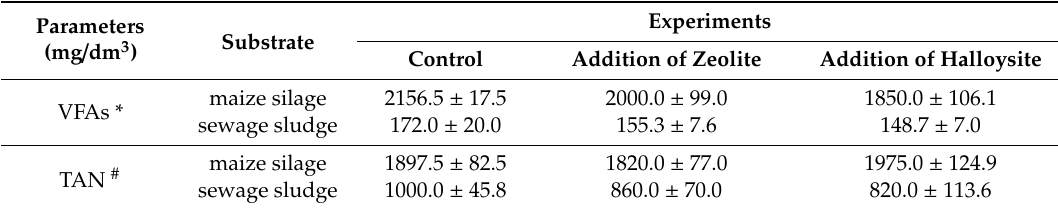
Table 4. Final volatile fatty acids and total ammonia nitrogen concentration (mg / dm 3 ) in the batch anaerobic digestion process of maize silage and sewage